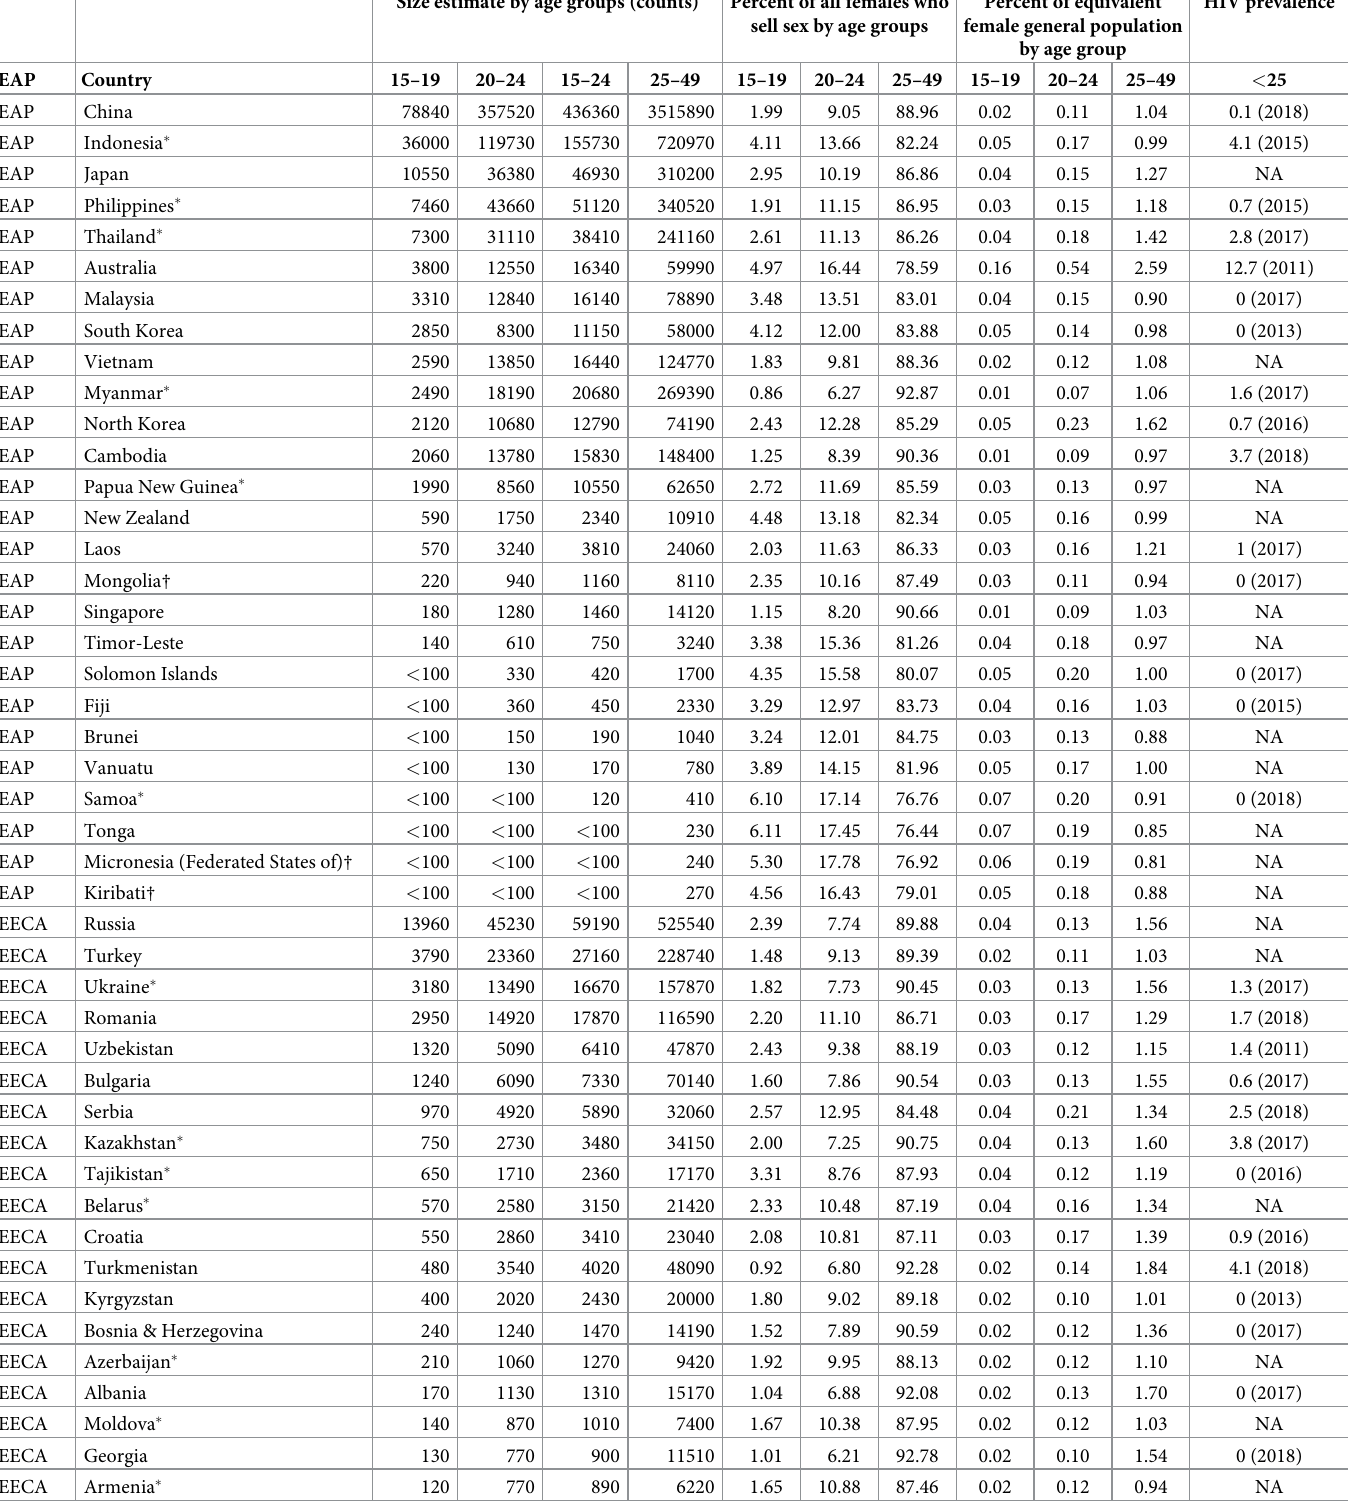
Table 3. Population size estimations for adolescent and young females who sell sex,